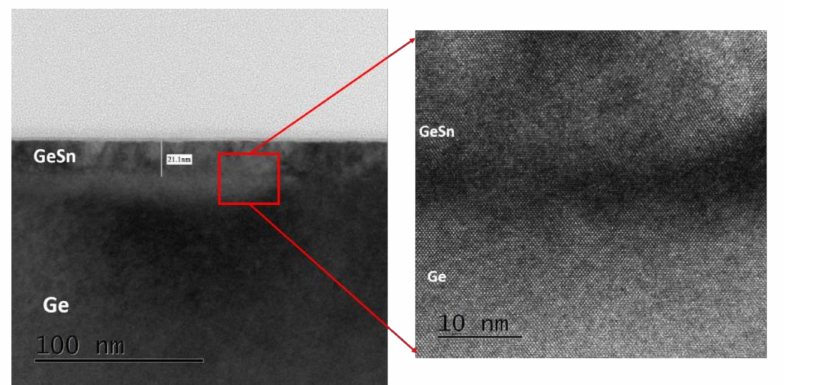
Figure 7. HRTEM cross-sectional images of Ge 0.82 Sn 0.18 (sample